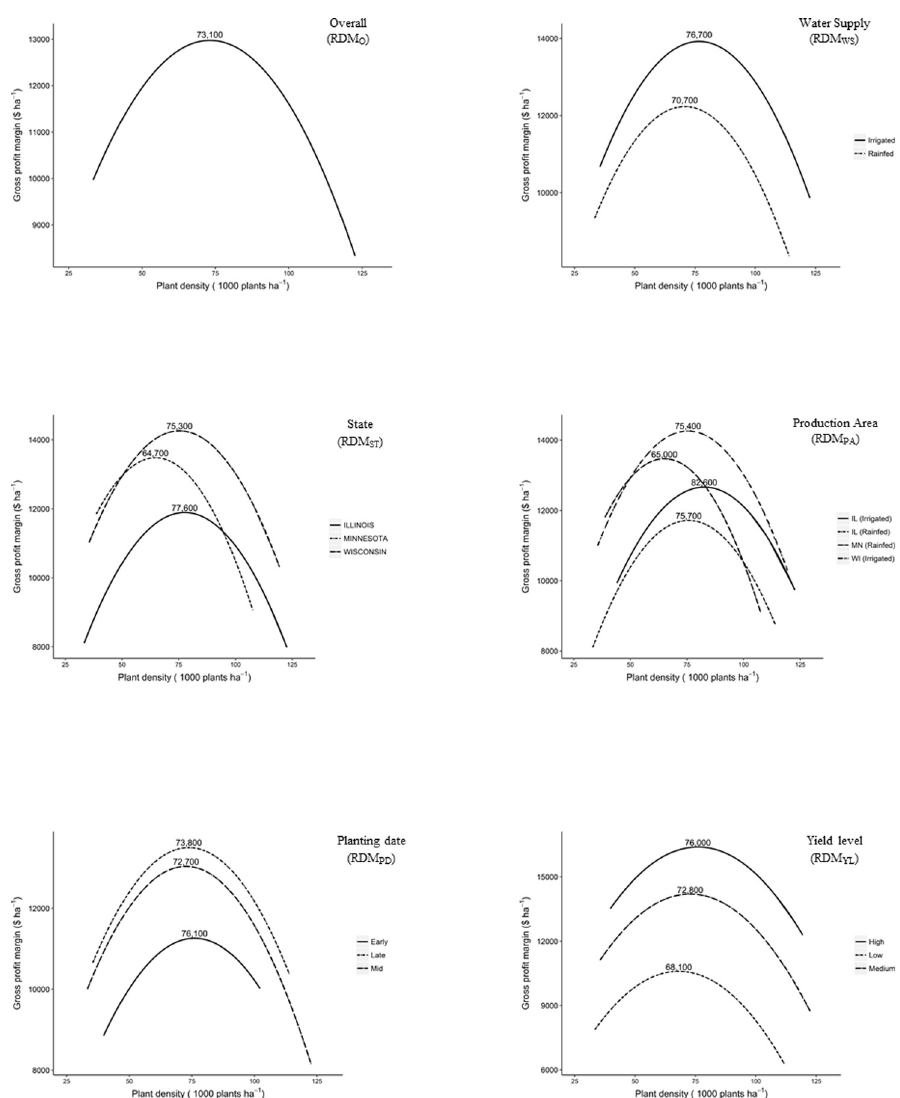
Fig 1. Linear mixed effects model for relationship between gross profit margin ($ ha -1 ) and plant density (plants ha -1 ) under six candidate recommendation domain models (RDM). The peak of each curve identifies the optimum plant density of each RDM